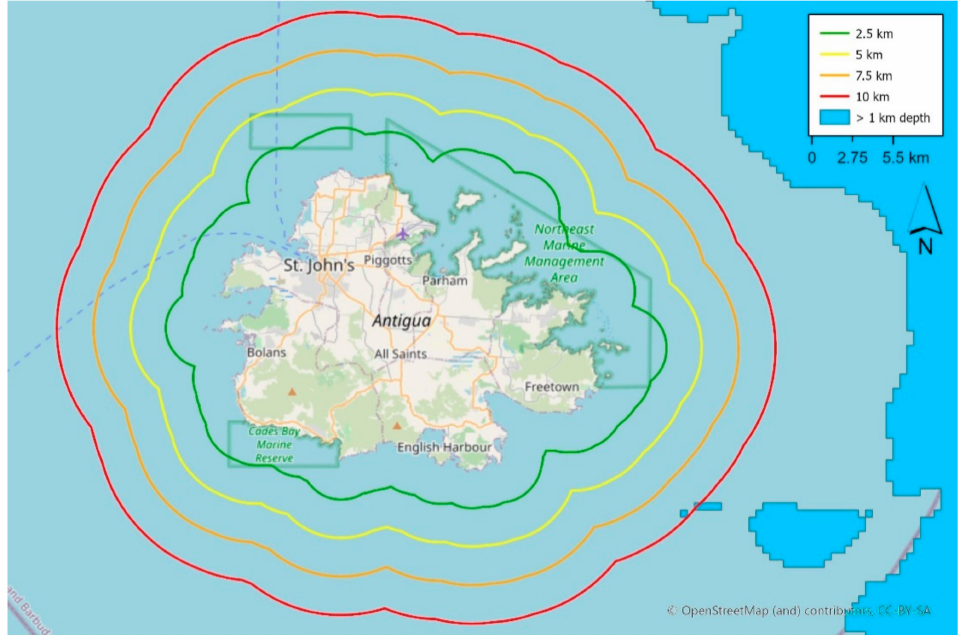
Figure 4. Map of Antigua with bathymetry contours and the blue area representing depths of greater than 1000 m and gray for less than 1000 m. Other contours are equidistant from the coast at 2.5 km (green), 5.0 km (yellow), 7.5 km (orange) and 10 km (red). Marine protected areas are shown within the light green